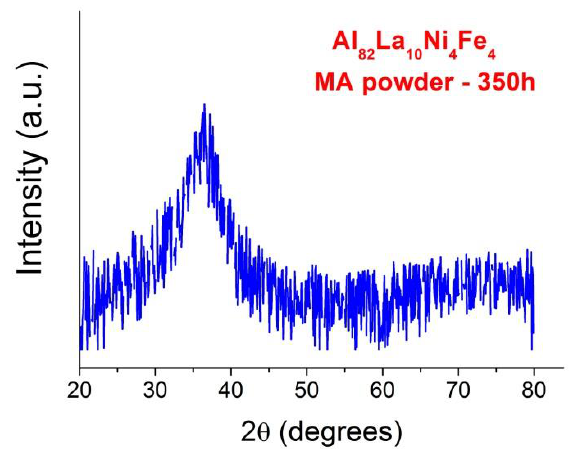
Figure 1. XRD (X-ray diffraction) pattern of the mechanically alloyed Al 82 La 10 Fe 4 Ni 4 powder.